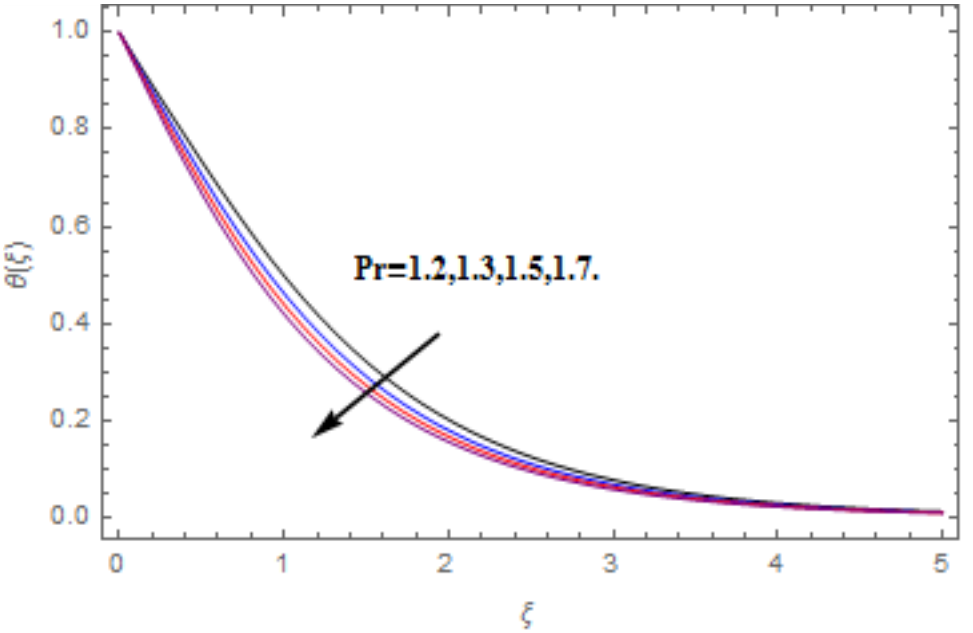
θ ( ξ ) against Pr, when M = ψ = 0.2, Nt = Nb = 0.5, Le = 1.0, Ec = 1.0, Figure 13. Figure 13. Varation in γ = 0.1, κ = 1.0. Molecules 2020 , 25 , x FOR PEER REVIEW